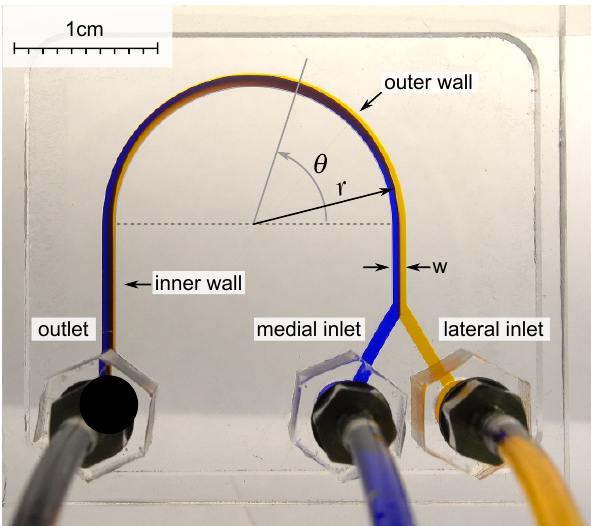
Figure 1. A microfluidic chip from PMMA with U-shaped microchannel with a width w = 920 µ m, a height of 500 µ m, and a radius of curvature r = 10 mm was used for experimental investigation. The liquid with two different dyes was pumped into the medial and lateral inlets with the same flow rate. The angle θ was measured from the start of